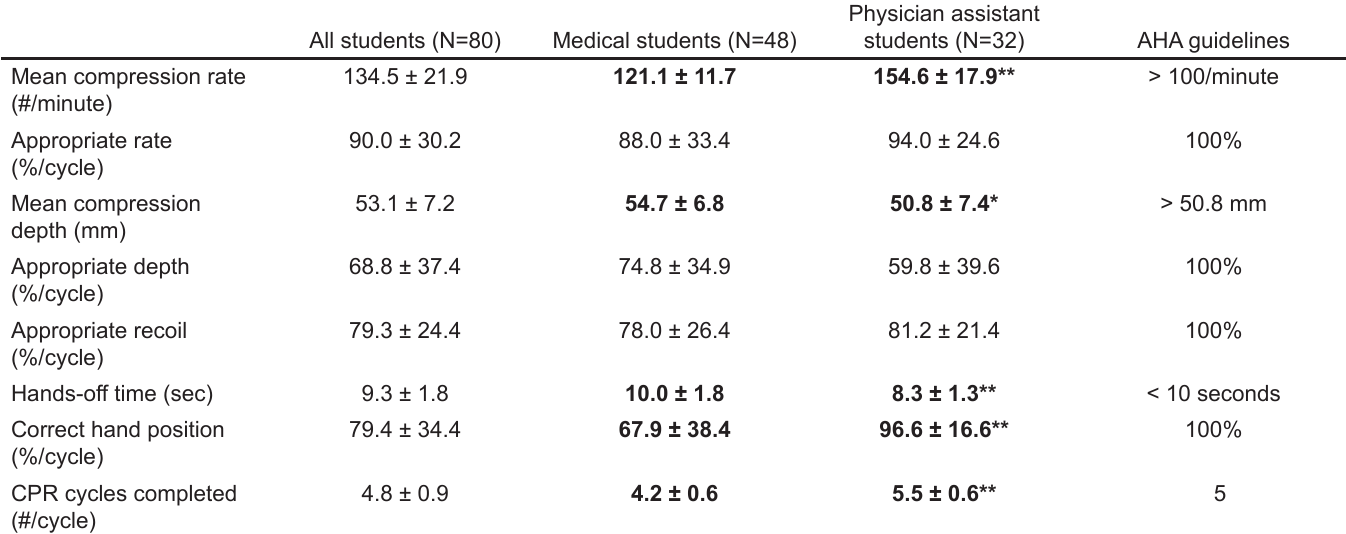
Table 2. Compression data across student type.